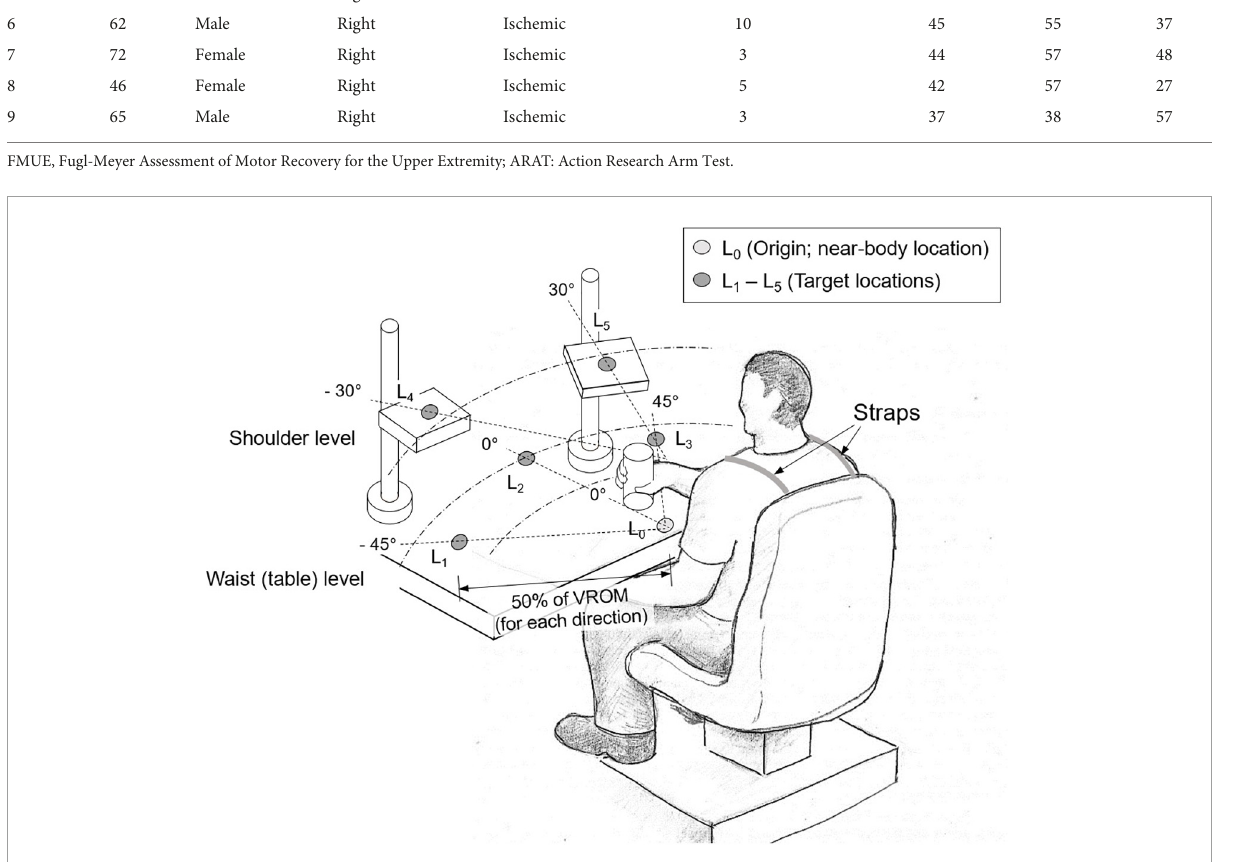
FIGURE1 Experimental setup. Subjects were asked to first transport a cylindrical object from the near-body location (L 0 ) to one of the target locations (L 1 –L 5 ) (“transport” task), which were determined as 50% of their voluntary range of motion (VROM) in each direction. Then they retrieved the object from the target location back to the original location (“retrieve” task). L 1 and L 4 were located in the contralateral to the more-impaired side, and L 3 and L 5 in the ipsilateral to the more-impaired